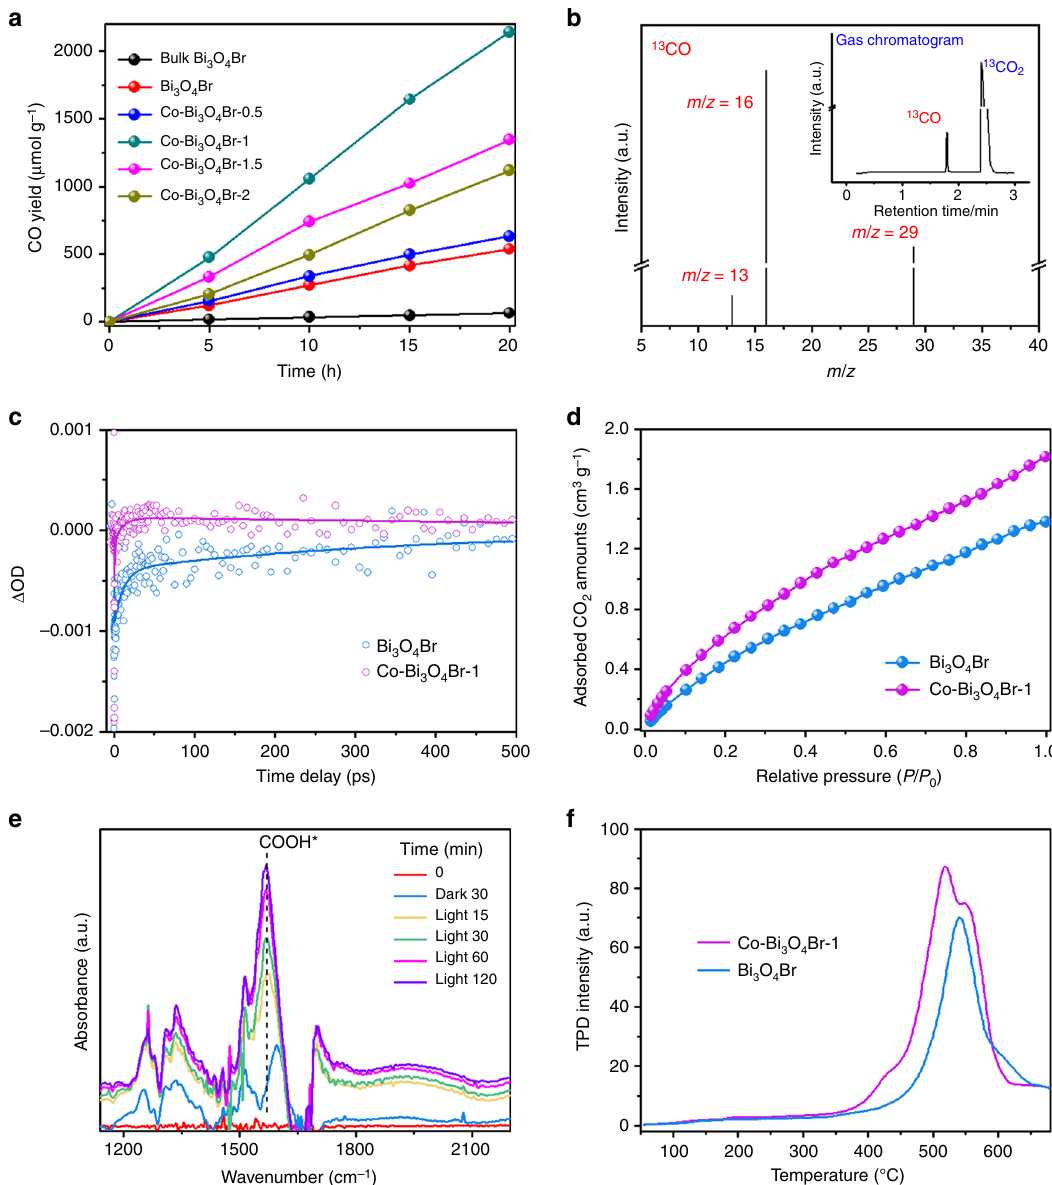
Fig. 3 Evaluation of CO 2 photoreduction performance and mechanism insight. a Photoreduction of CO 2 into CO over Bi 3 O 4 Br and Co – Bi 3 O 4 Br materials, b mass spectra of 13 CO ( m / z = 29) produced over Co – Bi 3 O 4 Br-1 in photoreduction of 13 CO 2 , c ultrafast TA spectra of Bi 3 O 4 Br and Co – Bi 3 O 4 Br, d CO 2 adsorption isotherms of Bi 3 O 4 Br and Co – Bi 3 O 4 Br-1, e in situ FTIR spectra for the CO 2 reduction process on the Co – Bi 3 O 4 Br-1, f CO TPD spectra of Bi 3 O 4 Br and Co – Bi 3 O 4